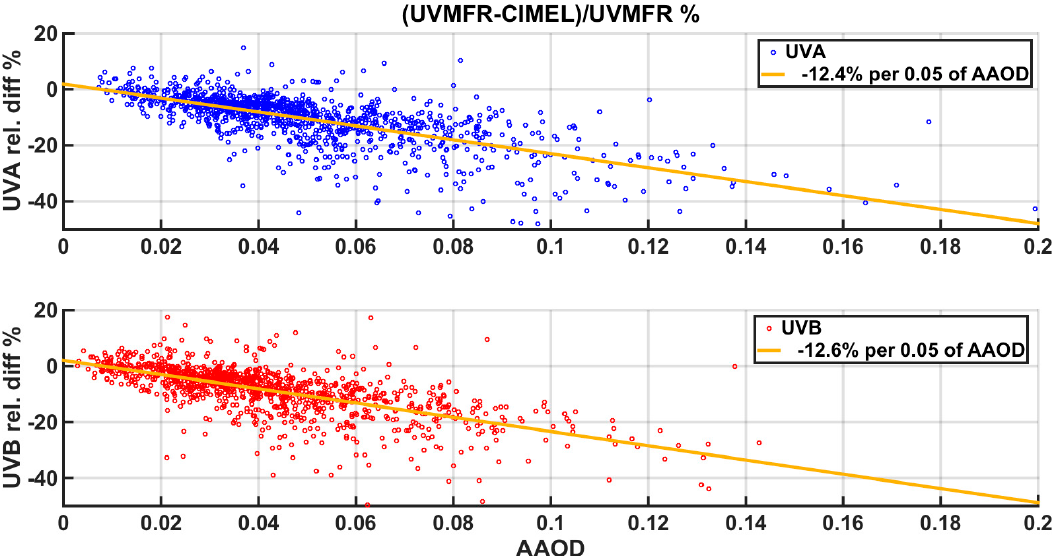
Figure 6. Relative difference in UVA ( upper plot ) and UVB ( lower plot ) with respect to AAOD, calculated with UVMFR and CIMEL SSA inputs as described in Table 1.